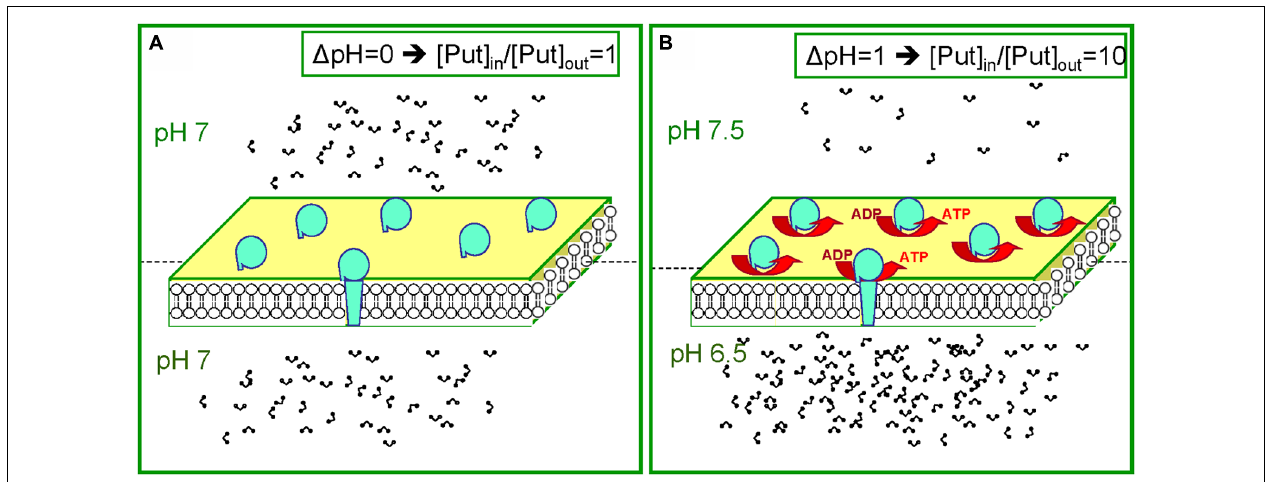
FIGURE 3 |The dual behavior of the Put pool during dark and light. (A) Equal distribution of protons leads to equal distribution of PAs (for example during the dark). (B) Establishment of a (cid:2) pH between the two compartments leads to unequal distribution of PAs. Note in b that for (cid:2) pH = 1 ten times more Put will accumulate in the acidic